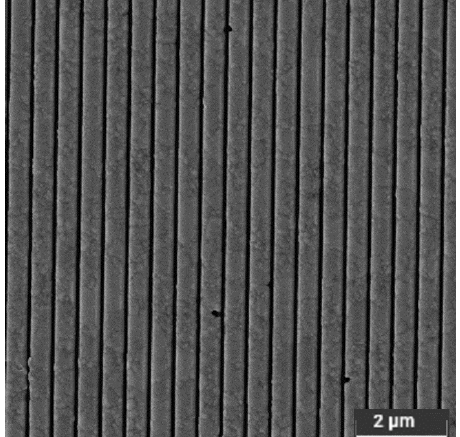
Figure 6. Top view SEM image of the FIB patterned 1D silver grating characterized by a pitch of ( 537 5 ) nm, a dot width of ( 451 4 ) nm and therefore a DC of 0.84. ± ±